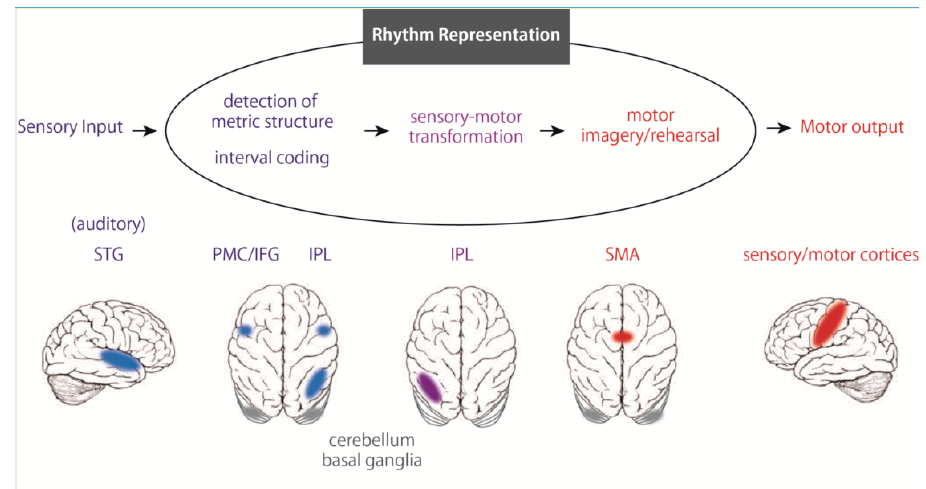
Figure 2. Hypothetical model of rhythm processing after sensory input, the premotor cortex (PMC) / inferior frontal gyrus (IFG) and inferior parietal lobule (IPL) receive auditory rhythm information from the superior temporal gyrus (STG). The sensory rhythm information is stored in the fronto-parietal network. During rhythm reproduction, the IPL transforms the temporal information into the motor sequence of the rhythm, and the supplemental motor area (SMA) reproduces the rhythm through various body parts while monitoring the output with the feedback signals from the somatosensory / motor cortices. Subcortical regions including the basal ganglia and cerebellum also play an important role in rhythm